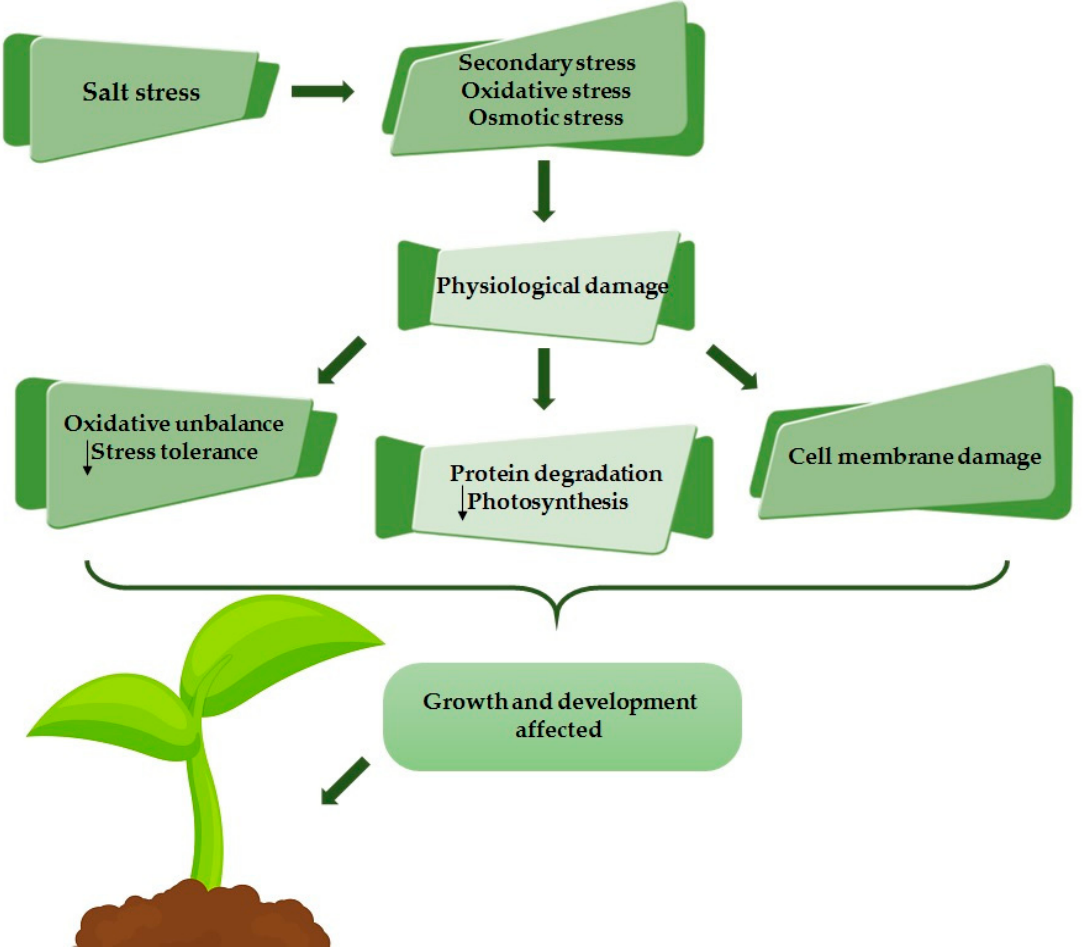
Figure 2. Some of the effects triggered by salt stress on plants.